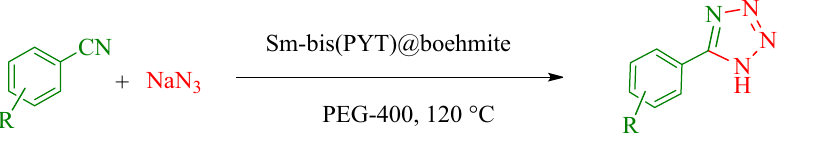
Figure 11. The general method used to synthesize 5-substituted 1H-tetrazoles in presence of Sm-bis(PYT)@ boehmite nanocatalyst.